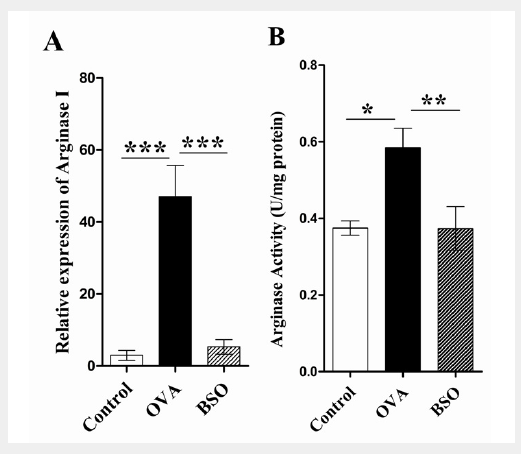
Black seed oil diminished the mRNA expression and activity of arginase. The mRNA expression of arginase І was determined by real time RT-PCR in the lung of experimental rats whereas β-actin gene was amplified as reference (A). Total arginase activity was determined by photometry method in the lung homogenate of lung (B). This experiment used 10 rats for each group. Data shown as mean ± S.E.M. * P <0.05, ** P <0.01, *** P <0.001 compared between two